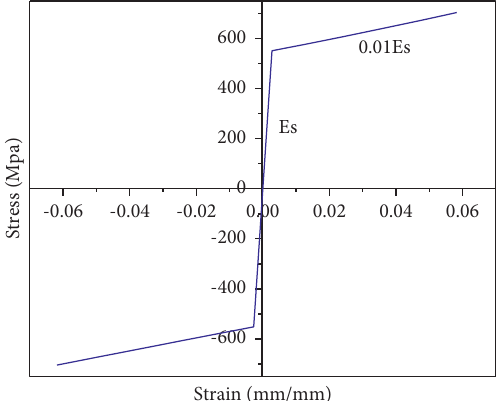
Figure 6: FE analysis steel bar material